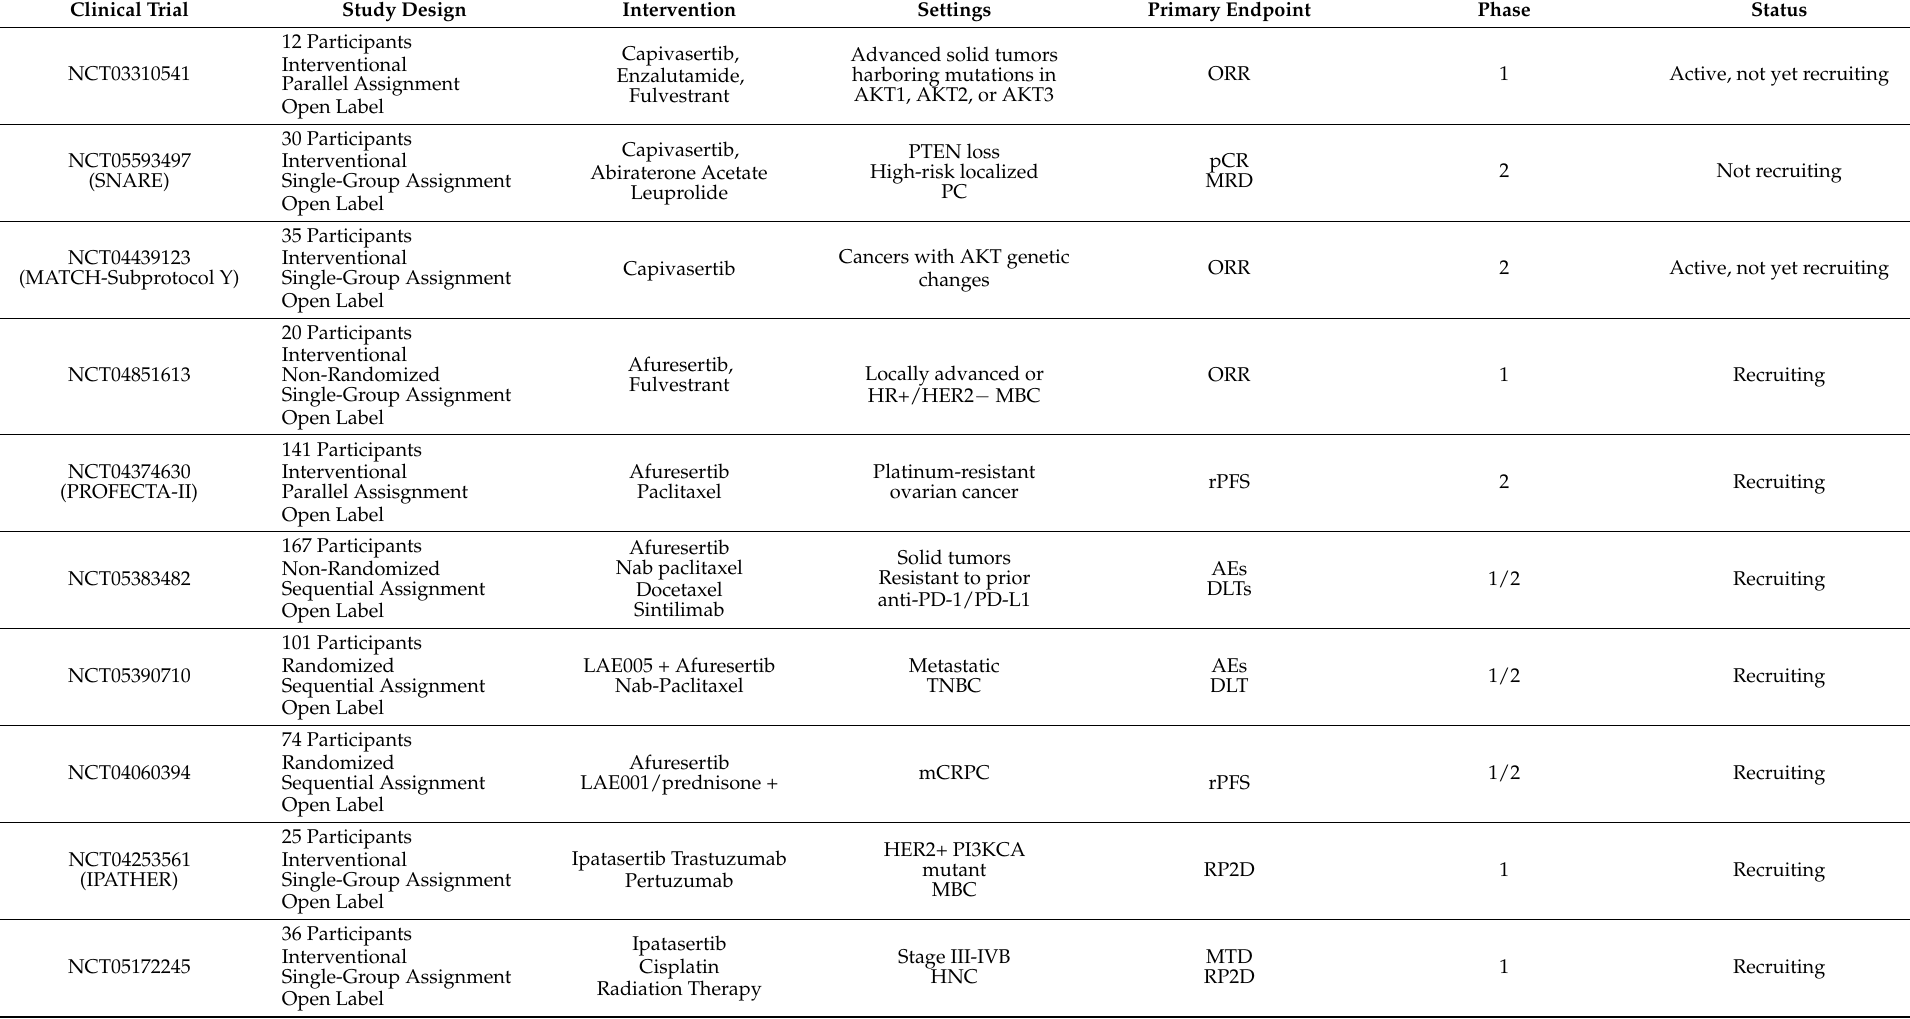
Table 2. Summary of ongoing phases I–III trials with AKT-inhibitors in